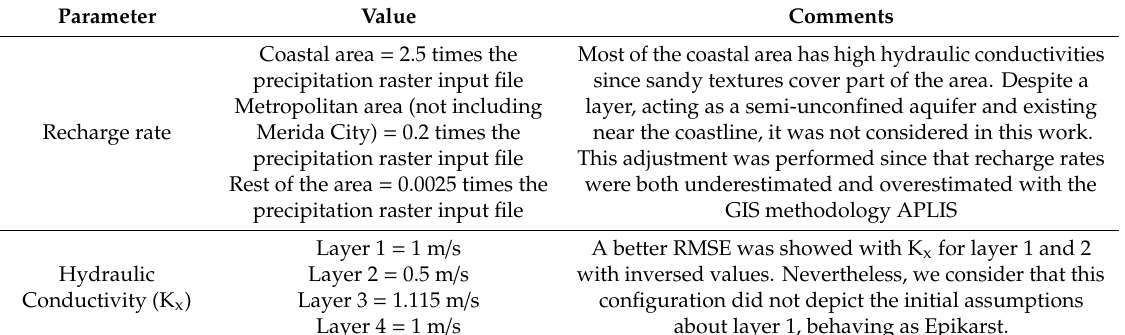
Table 2. Parameters obtained after calibration to run the transport